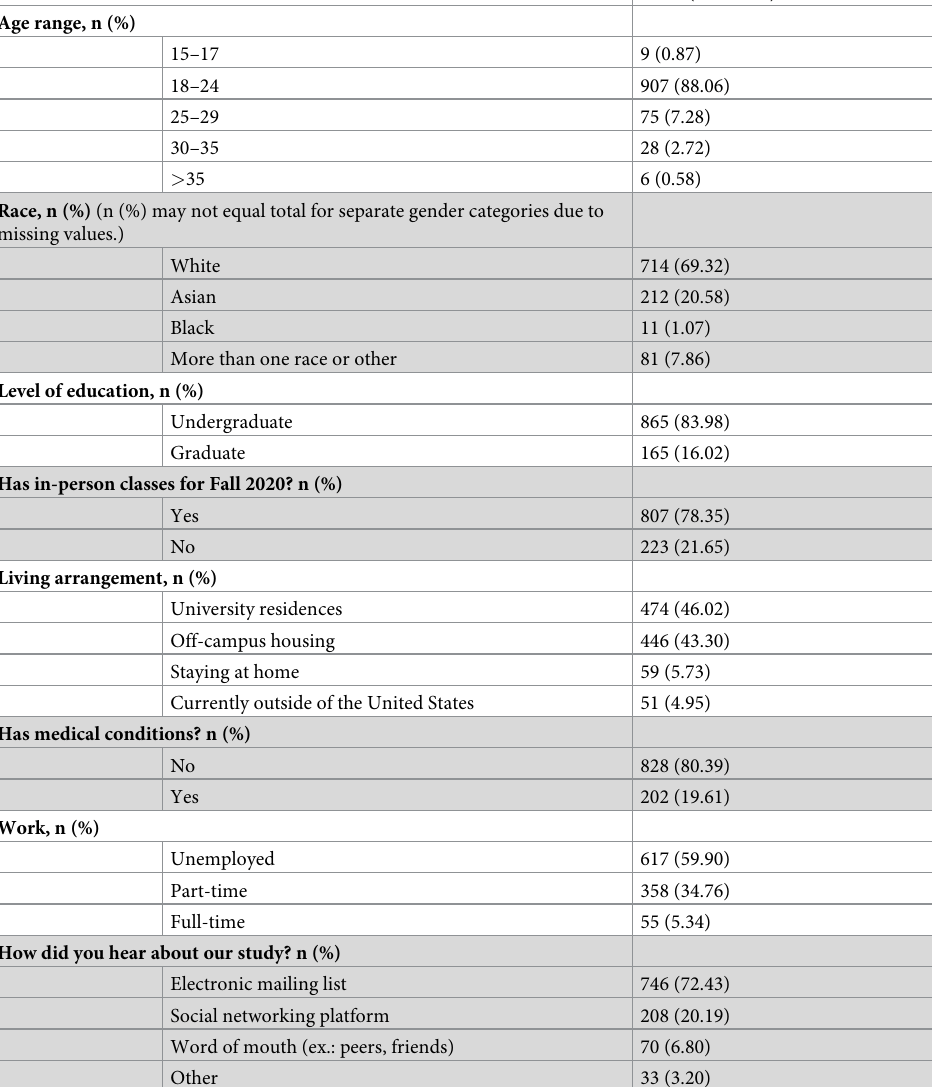
Table 1. Demographics of overall population in quantitative study.